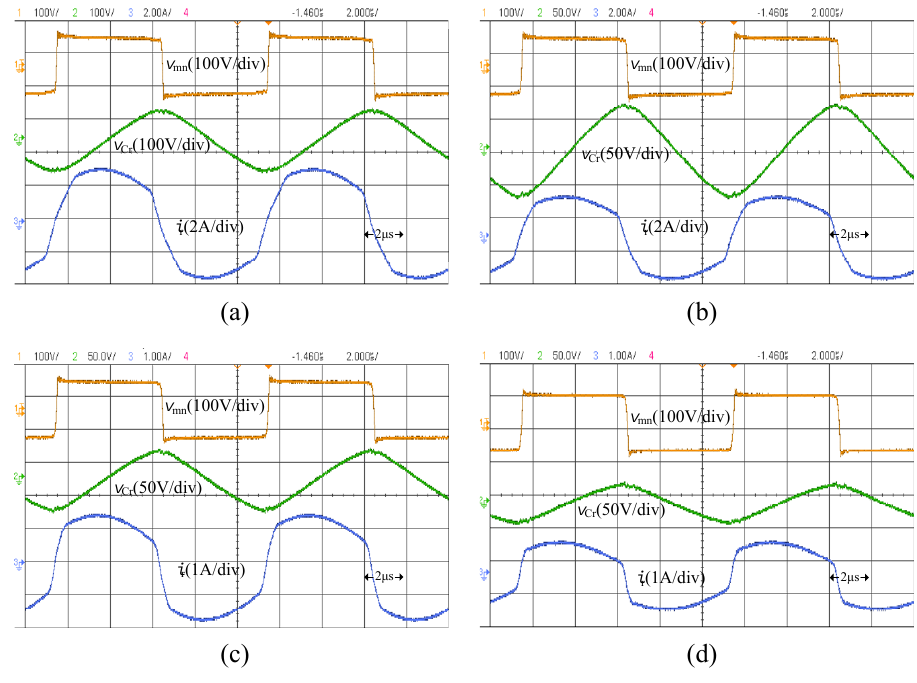
Figure 14. Experimental square voltage v mn , capacitor voltage v Cr , and resonant current i r at different power levels: ( a ) 200 W, ( b ) 150 W, ( c ) 100 W, and ( d ) 50